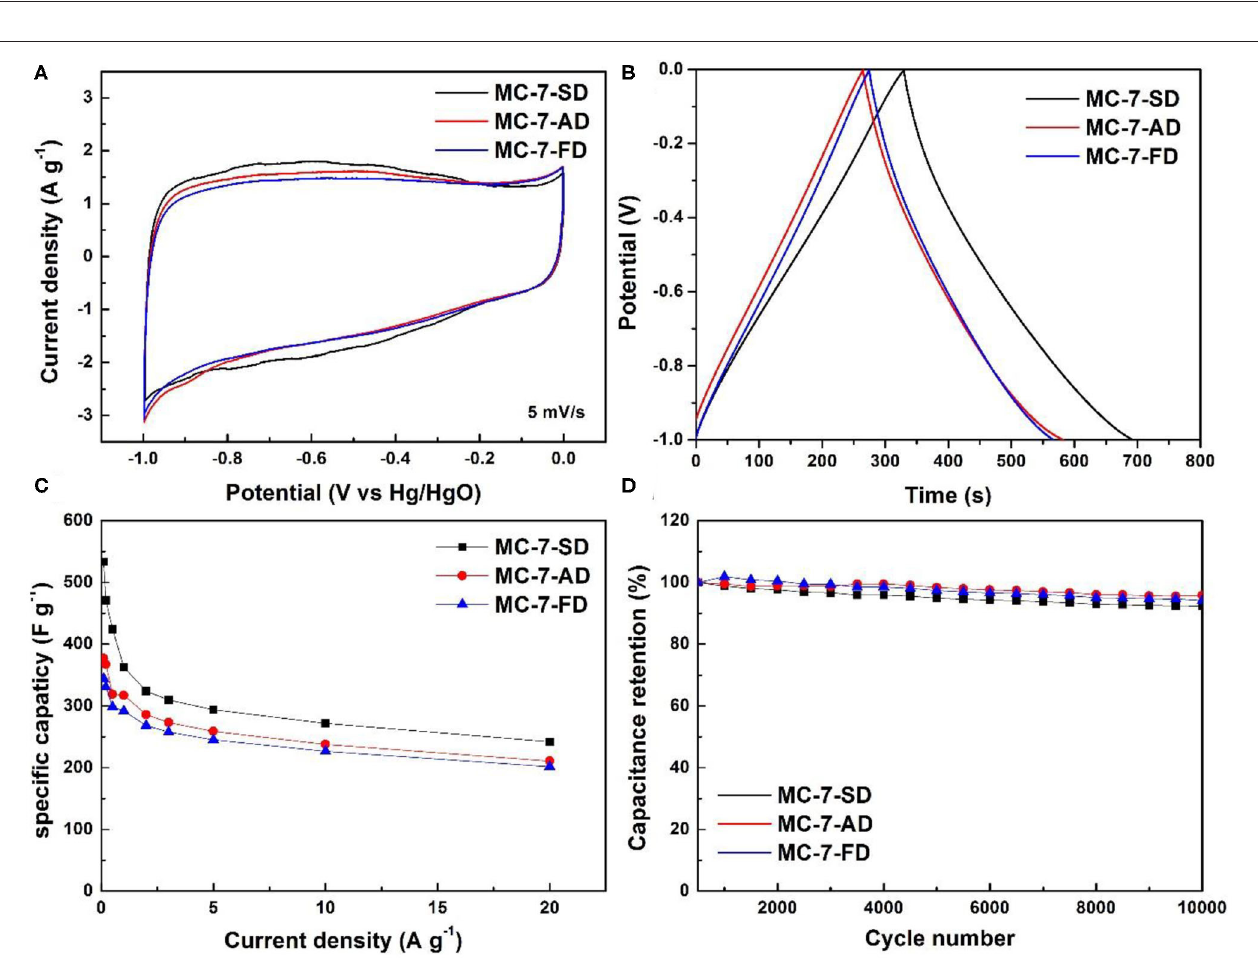
FIGURE 5 | (A) Cyclic voltammetry curves at 5mV s − 1 , (B) galvanostatic charge/discharge curves at 1A g − 1 , (C) specific capacitance of MC-7-SD, MC-7-AD, and MC-7-FD and (D) cycle performance of MC-7-SD, MC-7-AD, and MC-7-FD at 5A g − 1 .